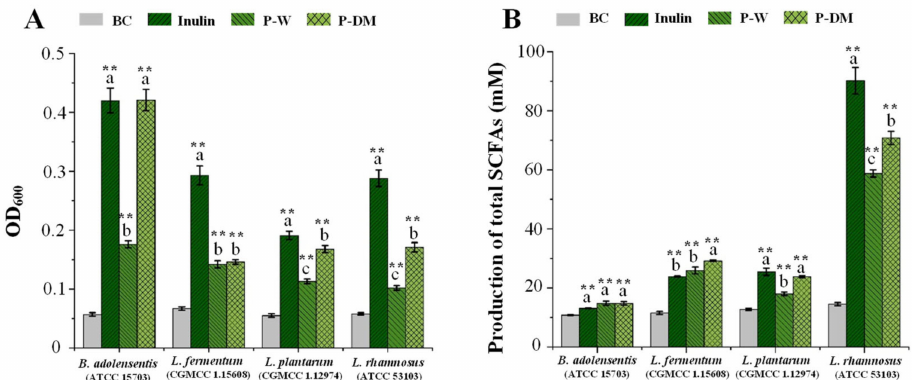
Figure 7. Effects of sweet tea polysaccharides on the growth ( A ) of four probiotic strains and related impacts on production of total short-chain fatty acids ( B ). P-DM and P-W indicate polysaccharides extracted from sweet tea leaves by microwave-assisted deep eutectic solvent extraction and hot water extraction, respectively; Significant differences ( p < 0.05) among the positive control, P-DM, and P-W are shown by data bearing different letters (a–c). Significant differences in the growth of probiotic strains and production of total short-chain fatty acids in the positive control, P-DM, and P-W vs. blank control (BC) are shown by ** p <